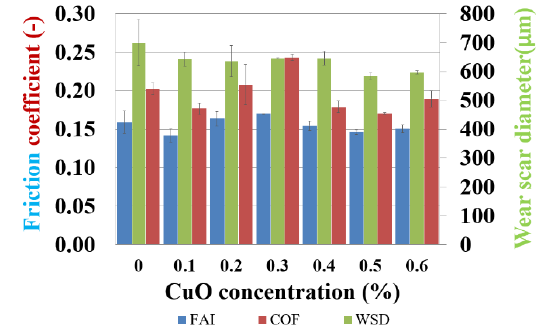
Figure 2. Evaluation of the identified tribological properties of the investigated oil samples